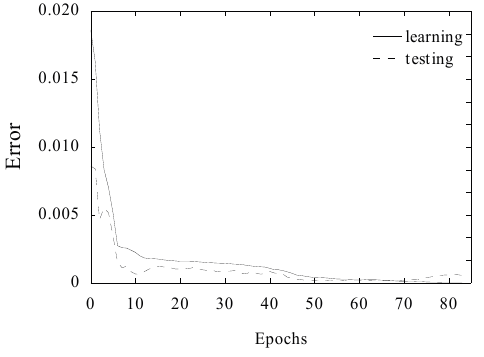
Figure 5. Example plot of net error alteration during learning process.